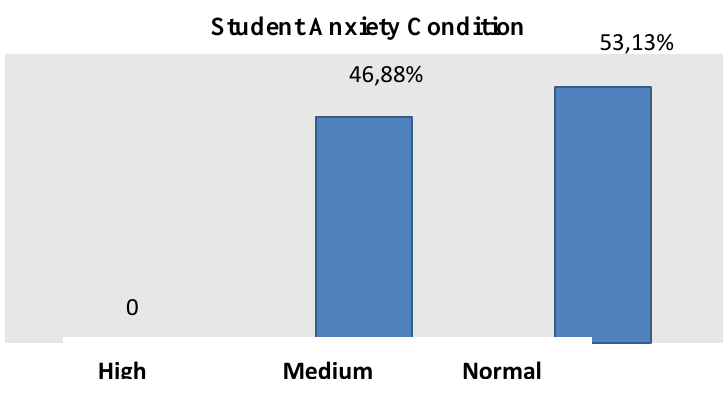
Figure 1: Student learning anxiety level